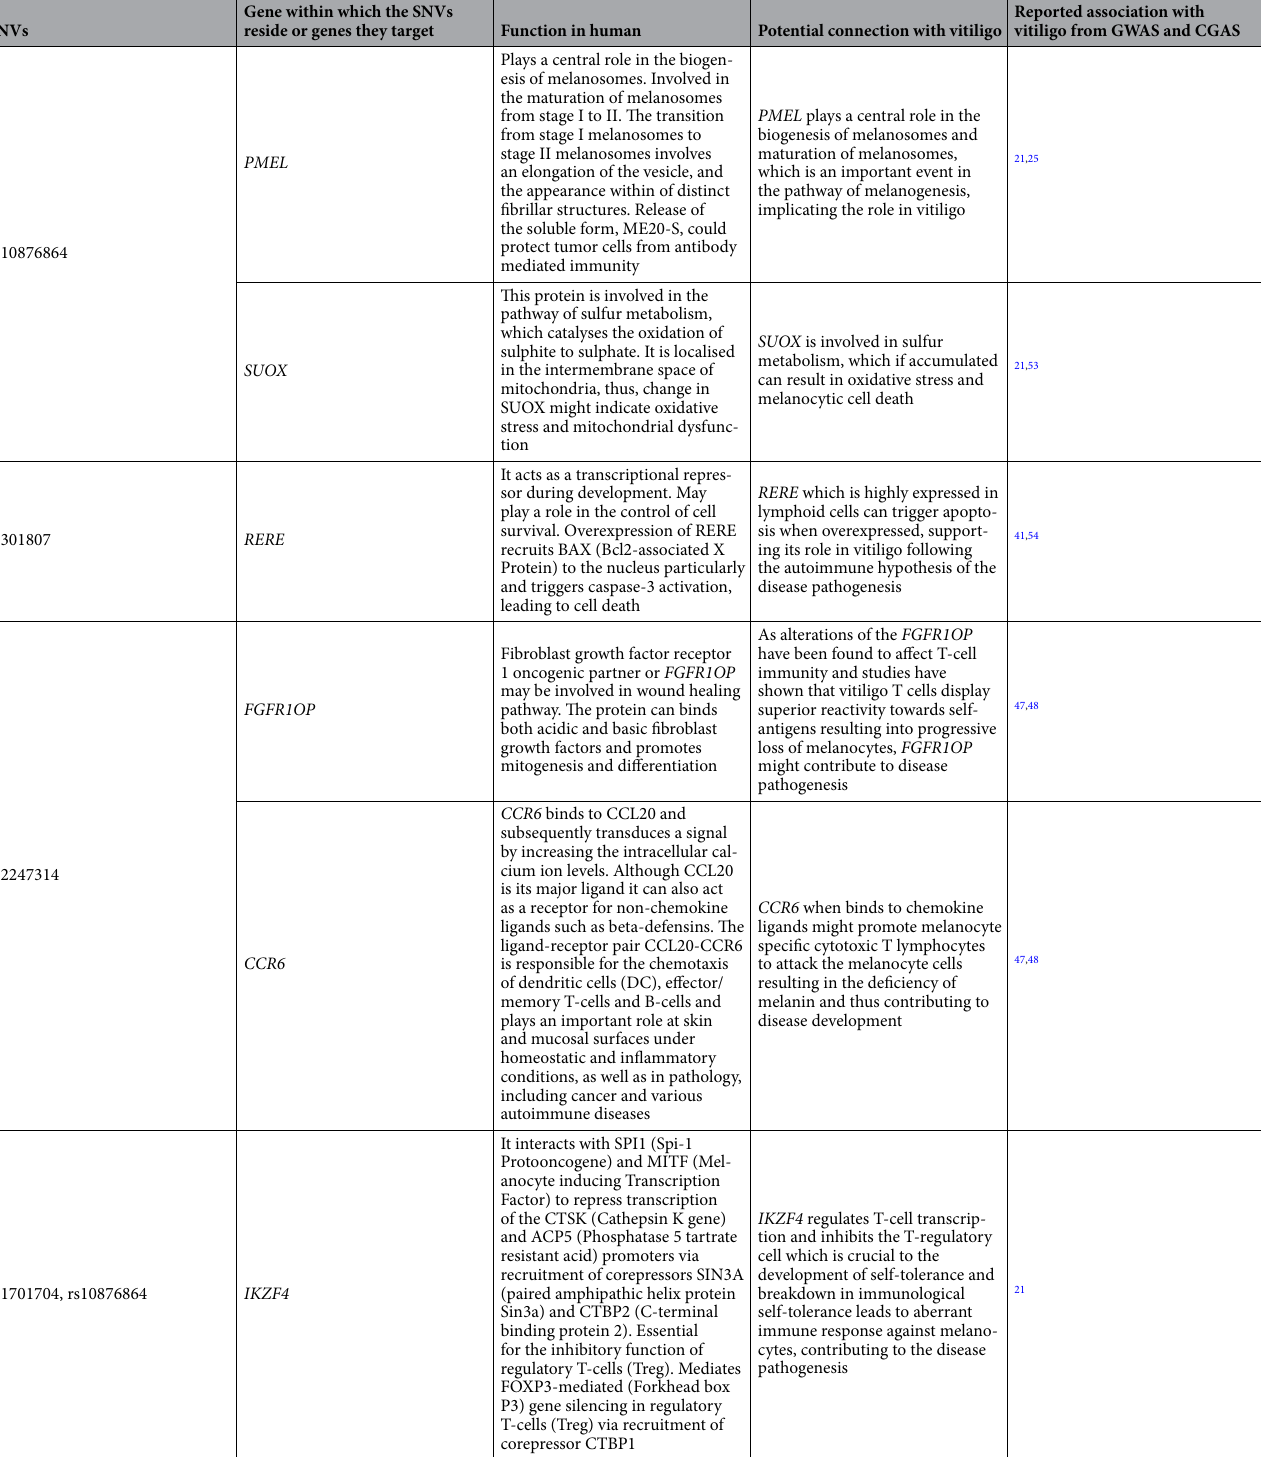
Table 4. Functional annotation of the thirteen prioritized variants along with the underlying genes in